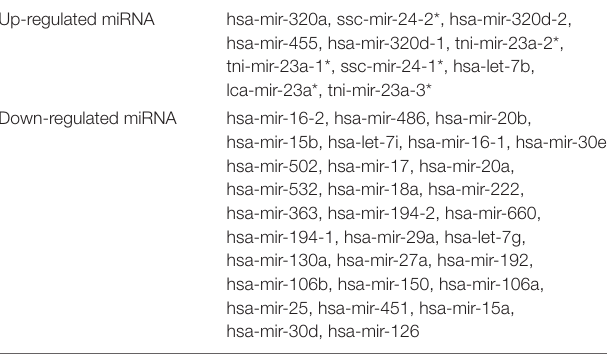
TABLE 2 | Differentially expressed DR specific miRNA.